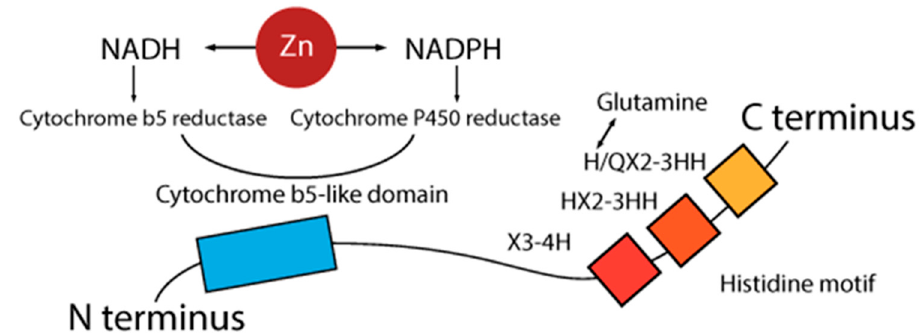
Figure 2. Schematic presentation of the structure of a ∆ 6 desaturase enzyme. A cytochrome b5-like domain is attached to the N-terminus and a histidine motif is located at the C-terminus. The histidine sequence is made of three histidine-rich motifs. The first histidine of the third motif is often replaced by glutamine. NADPH reductase has a Zn-dependent activity. NADH: nicotinamide adenine dinucleotide hydride; NADPH: nicotinamide adenine dinucleotide phosphate-oxidase.